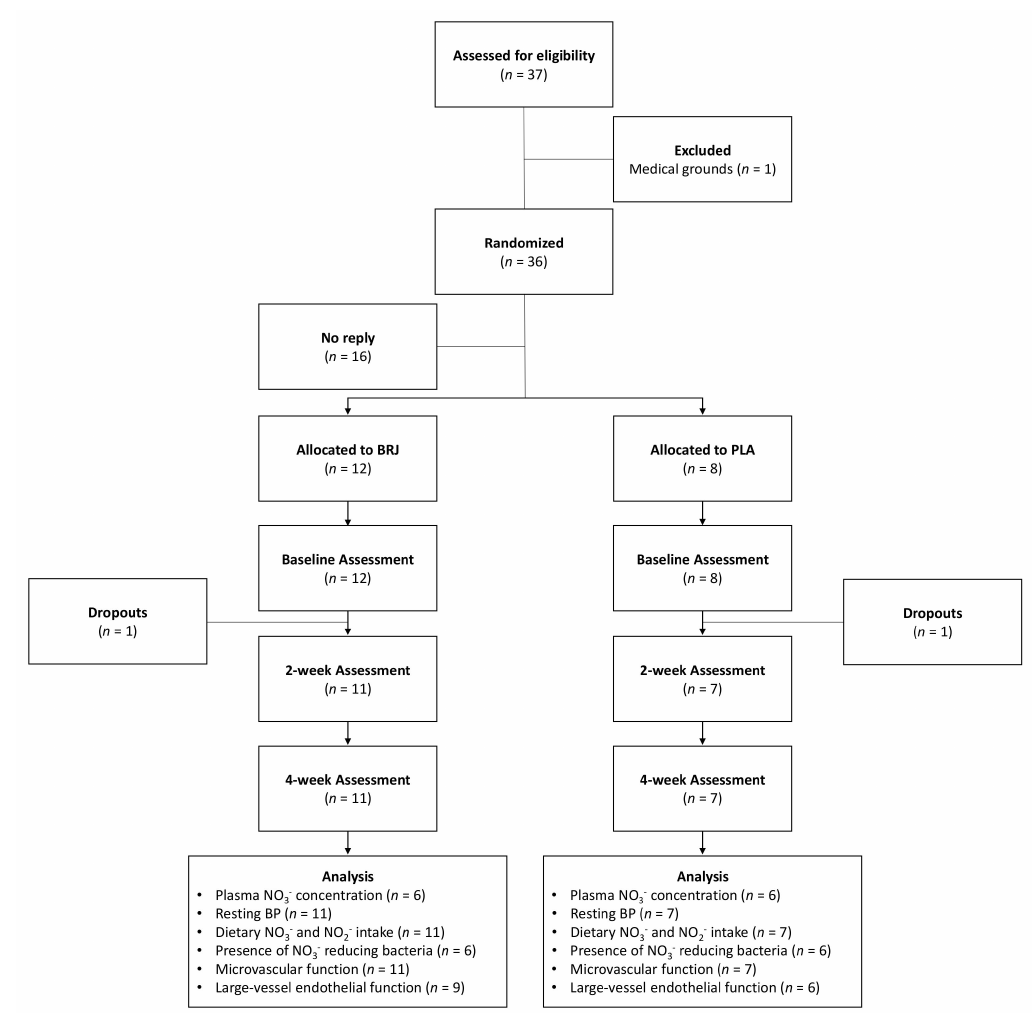
Figure 1. Consolidated standards of reporting trials (CONSORT) flowchart of study. BP = blood pressure; BRJ = beetroot juice; NO 3 − = nitrate and PLA =